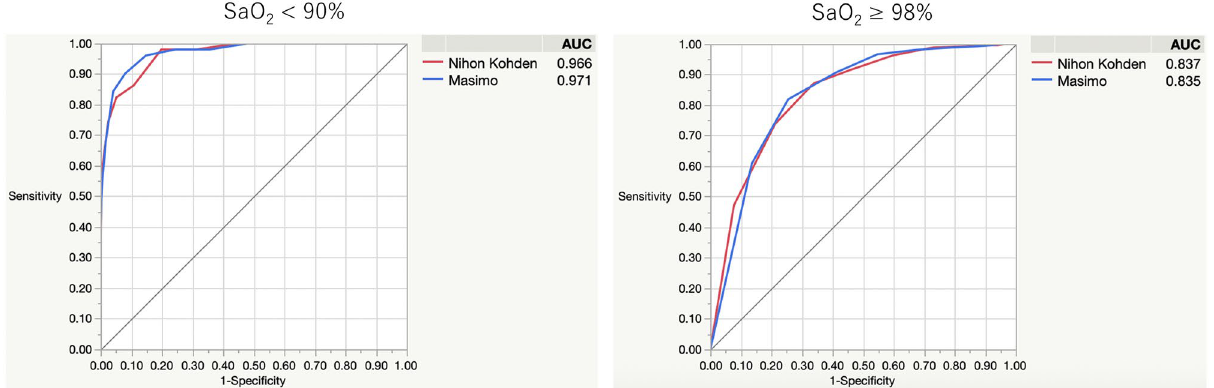
Figure 4. AUC comparison between Nihon Kohden SpO 2 and Masimo SpO 2 for patients with SaO 2 < 90% and SaO 2 ≥ 98%. The blue line represents Masimo SpO 2 measurements, and the red line represents Nihon Kohden SpO 2 . The vertical axis represents true positive rate calculated by sensitivity, and the horizontal axis represents false positive rate calculated by (1—specificity). To detect SaO 2 < 90%, the area under the receiver operating characteristic curves (AUCs) were 0.966 using the Nihon Kohden and 0.971 using the Masimo monitor. When cut off point was set at SpO 2 90% in Nihon Kohden and Masimo, its sensitivity and specificity were 62.8%